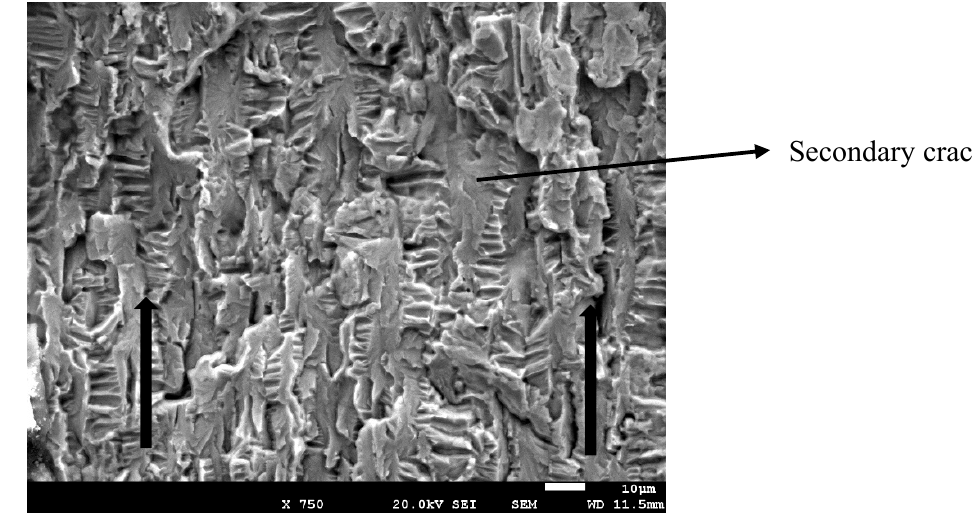
Figure 5. Crack propagation.